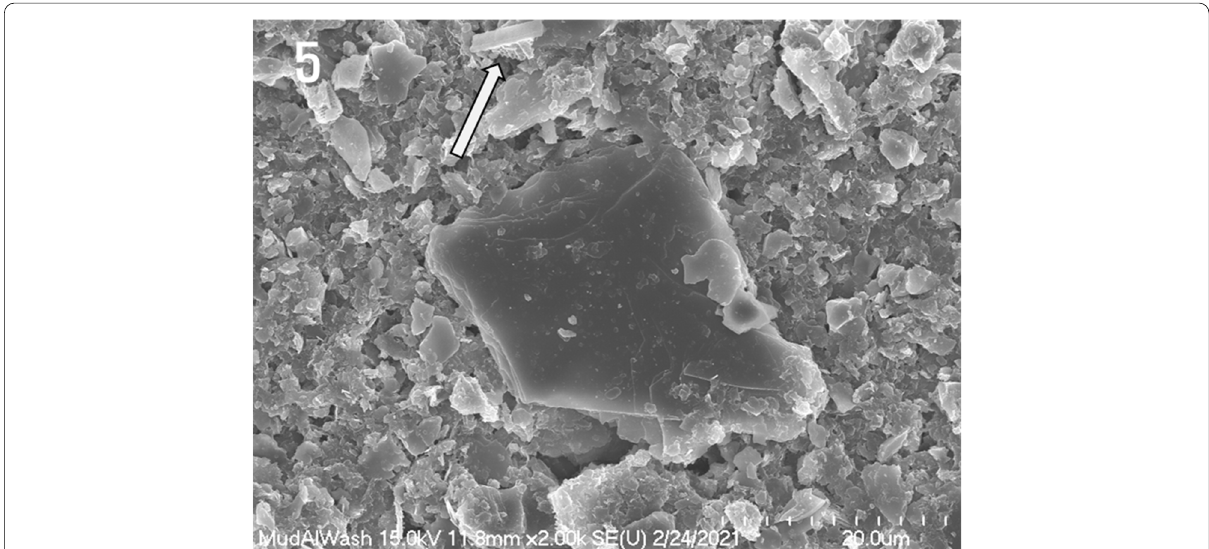
Fig. 5 Scanning electron micrograph of mud powder depicting a diatom frustule fragment (arrow) and clay mineral